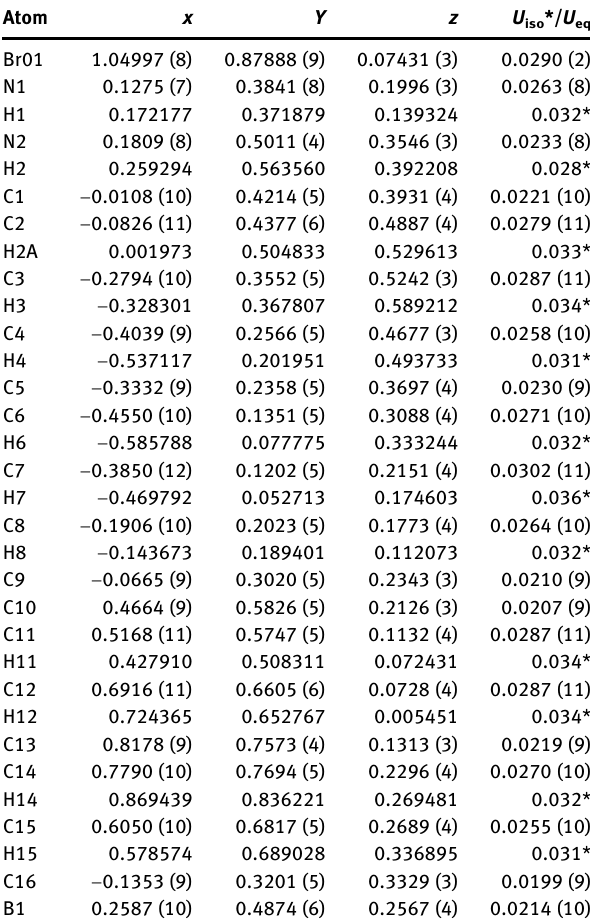
Table  : Fractional atomic coordinates and isotropic or equivalent isotropic displacement parameters (Å  ).